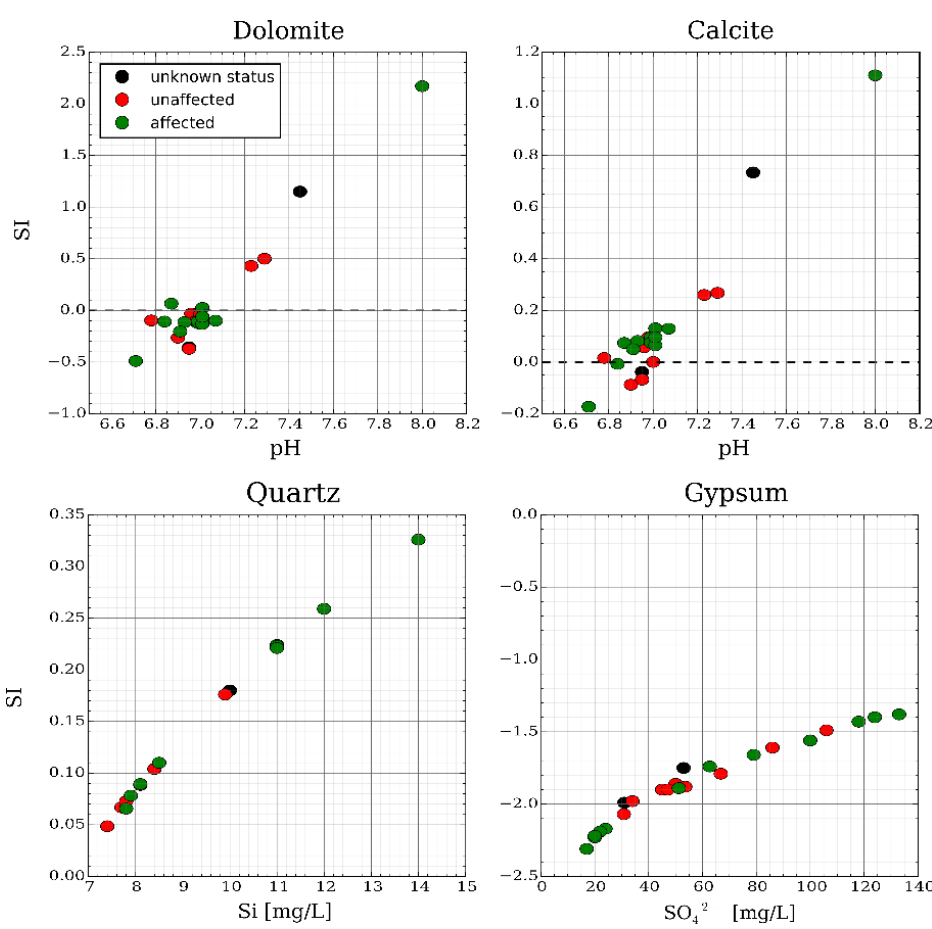
Figure 2. Correlation between the saturation index (SI) for dolomite (CaMg(CO 3 ) 2 ), calcite (CaCO 3 ), quartz (SiO 2 ) and gypsum (CaSO 4 ) with dissolved Ca, Si and SO 42 concentrations. The dashed line indicates mineral equilibrium (SI = 0) with minerals likely to precipitate at SI > 0 and dissolve at SI < 0. Calculations were performed by PHREEQC using the PHREEQC-2 thermodynamic database. Redoxconditionsrangedfromfullyoxygenatedtostronglyreducingwaters(Figures 3 and 4). Aerated water samples were thereby characterized by elevated dissolved oxygen and ni- trate concentration while reduced species (Fe(II), Mn(II)) were absent or occurred at very Mn(II) concentrations, while appreciable concentrations of oxygen and nitrate were